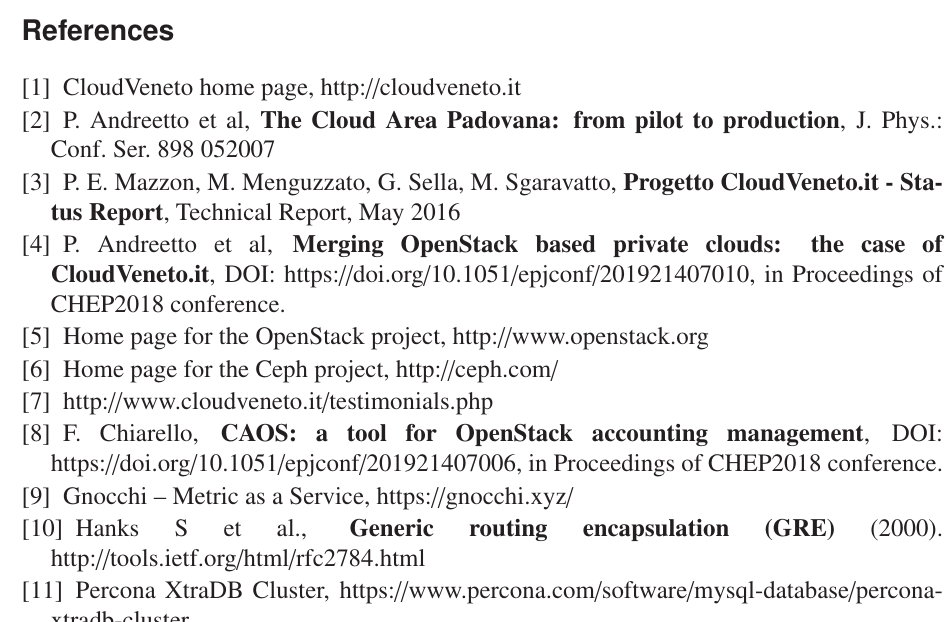
Figure 3. Architecture of CloudVeneto accounting system